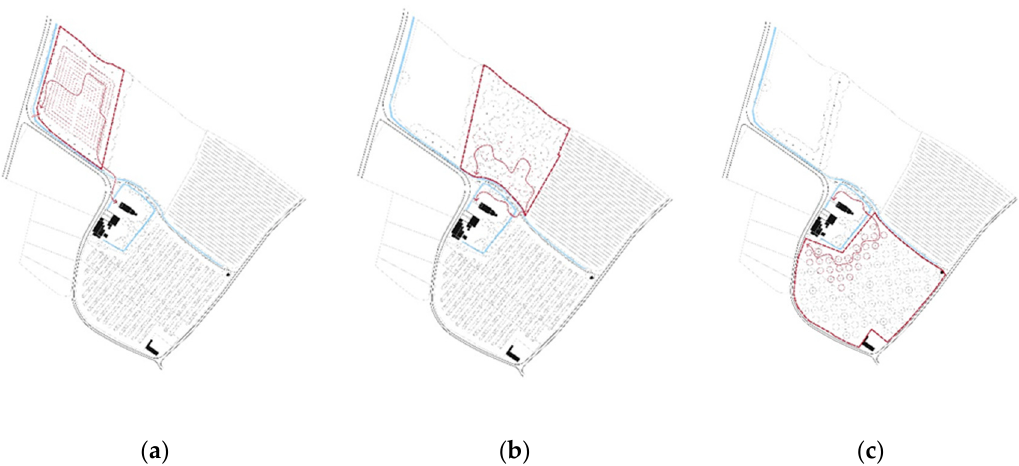
Figure 9. Situation plan of the St. Odulphus site and the surrounding fields: ( a ) Urn “cloister”: the graves are positioned parallel with the edges of the field and surrounded by a line of trees; ( b ) Urn forest: natural burial among irregular plantation of trees; ( c ) Urn orchard: the low stem orchard is replaced by a less dense high stem orchard with the graves positioned in circles around them.